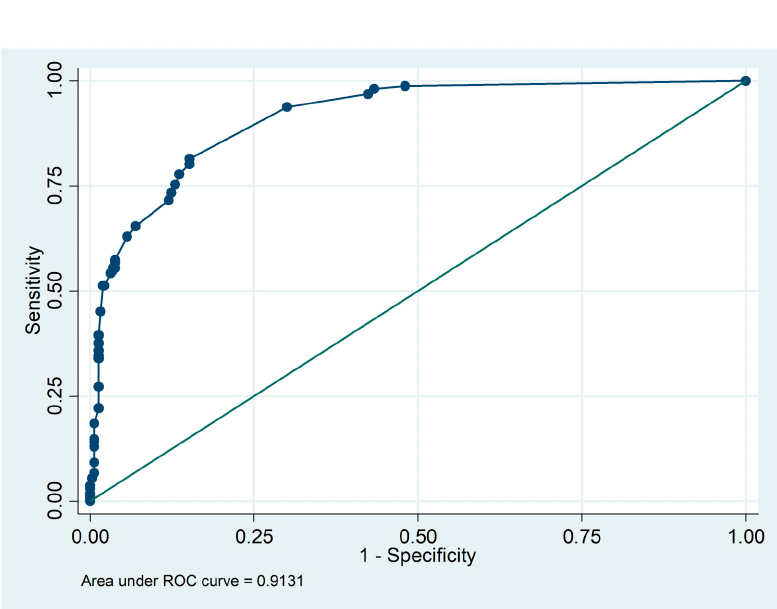
Table 3. Multivariable odds ratios (OR) and 95% confidence interval (CI) for Leptospirosis infection severity .